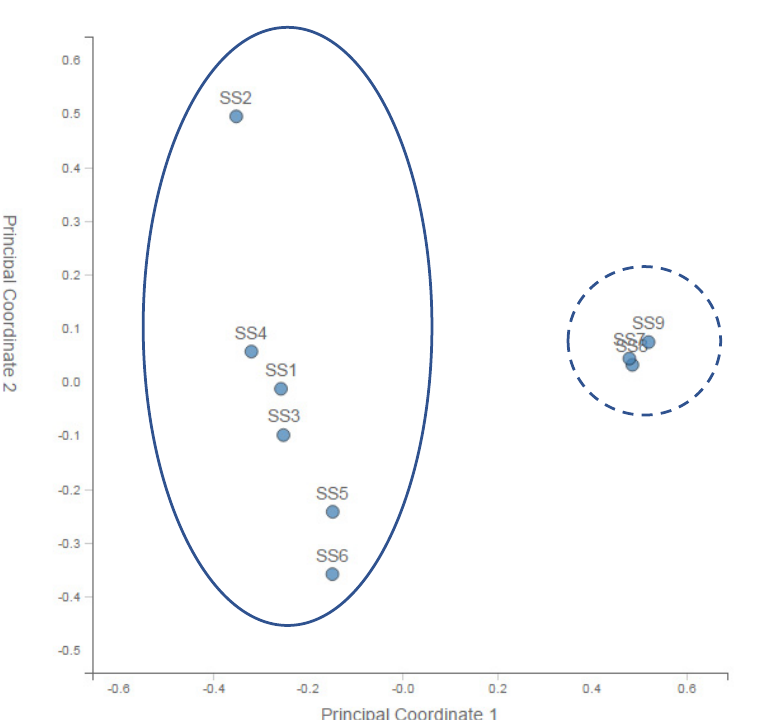
Figure 2. Principal coordinate analysis (PCoA) of the normalised relative abundance of all the preliminary samples at the genus level. SS—substrate sample. Solid line—upstream sites (1–6). Dashed line—downstream sites (8–9).